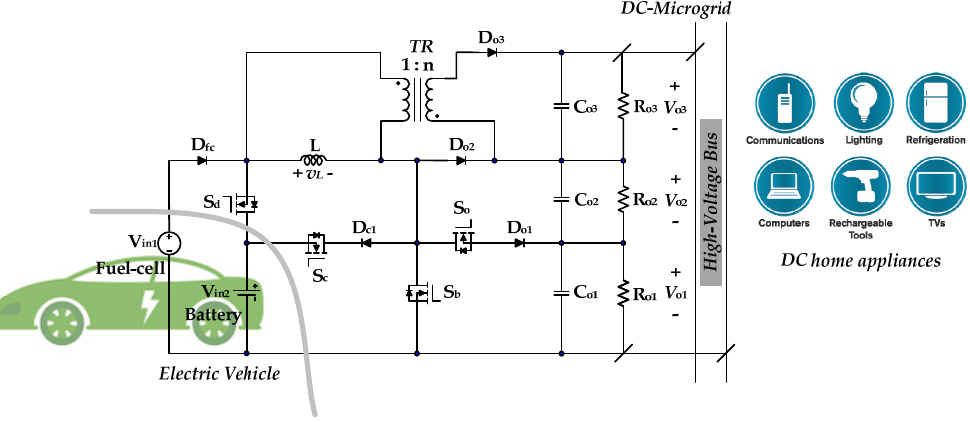
Figure 1. Proposed converter with two ‐ input, three ‐ output ports for a hybrid electric vehicle (HEV) connected to a dc ‐ microgrid system.